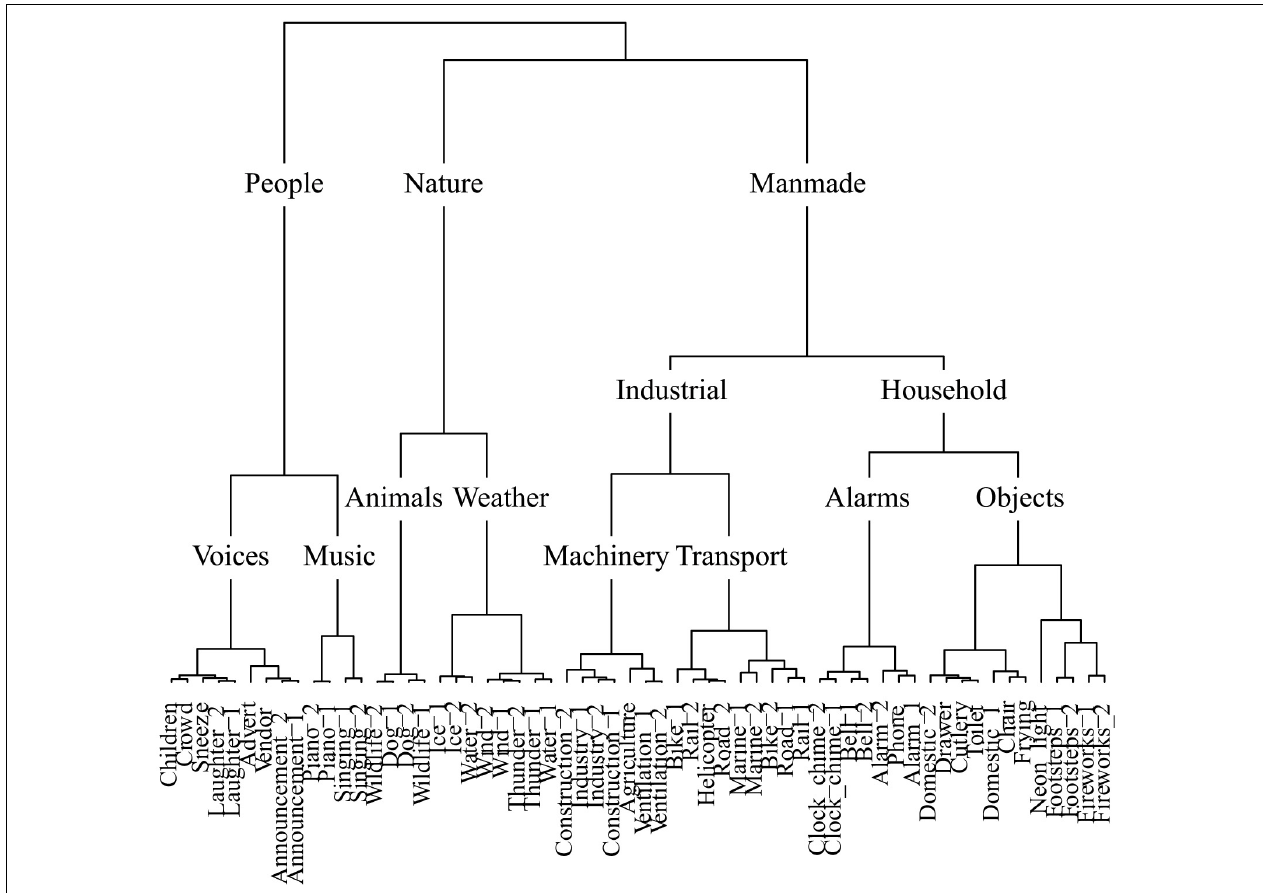
FIGURE 6 | The soundscape taxonomy generated by hierarchical cluster analysis of the principal dimensions resulting from correspondence